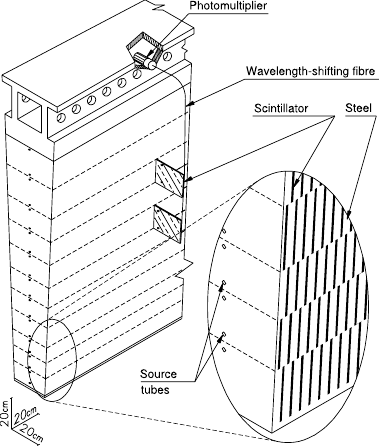
Fig. 1. Detailed sketch of a TileCal module showing its components and structure [1].